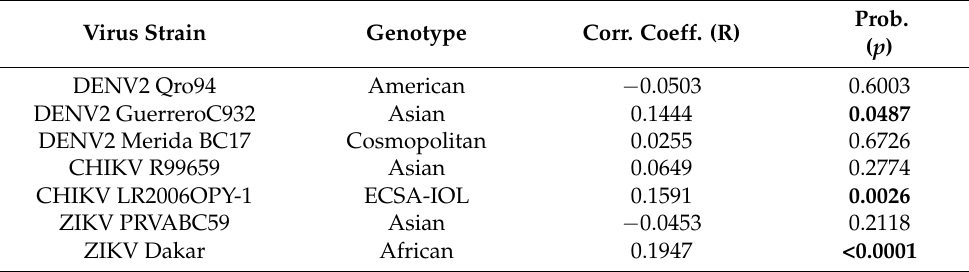
Table 4. Correlation analysis between the log10 (PFU/mL)/salivary gland and the log 10 (PFU/mL)/saliva acrossallindividualmosquitoesforeachofthesevengenotypes. Mosquitoes without an infected salivary gland were not included. p values that are bolded are significant at a threshold of p < 0.05. Virus Strain Corr. Coeff.